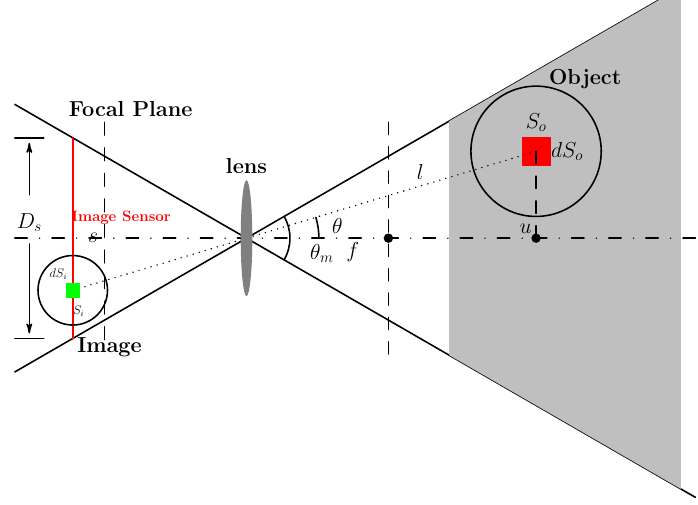
Figure 9. The 2D imaging model of a camera. The gray part is the effective sensing